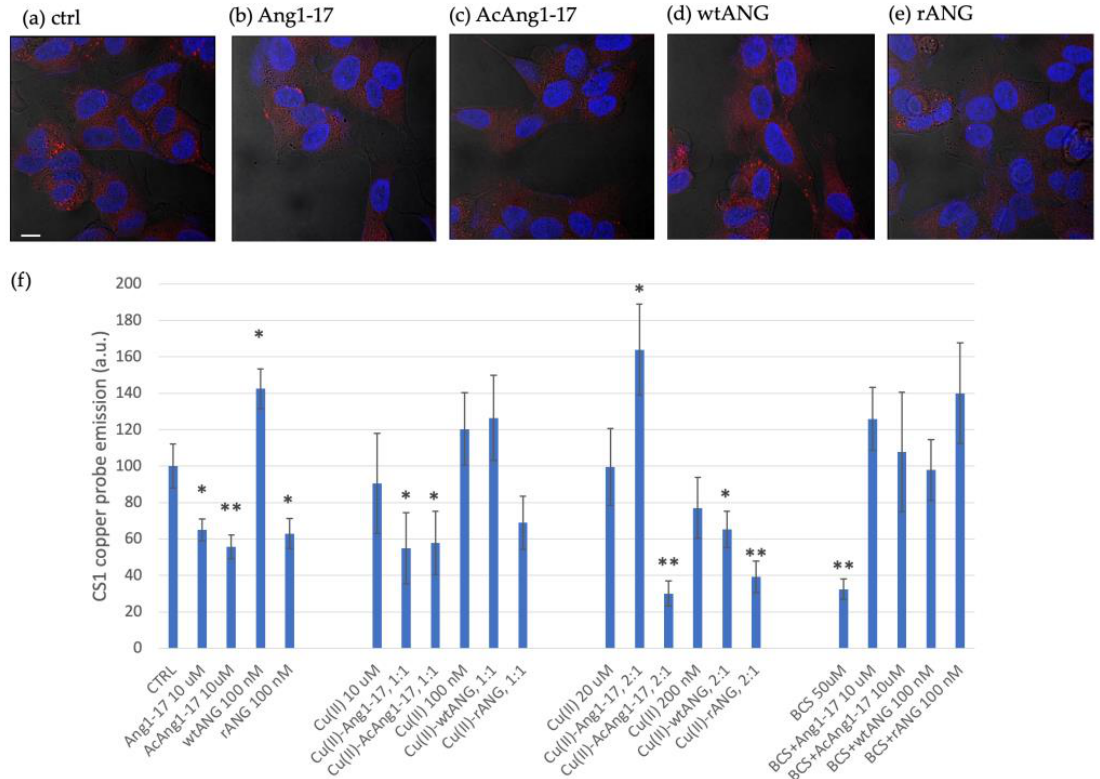
Figure 9. Representative confocal microscopy merged micrographs of fluorescence channels (in blue, nuclear staining, λ ex/em = 405/425–450 nm; in red, CS1-copper probe, λ ex/em = 543/550–600 nm) and optical bright field (in grey) of SH- SY5Y cells untreated ( a , negative control) and after 90 min of treatment with: ( b ) 10 µ M Ang1-17, ( c ) 10 µ M AcAng1-17, ( d ) 100 nM wtANG, and ( e ) 100 nM rANG. Scale bar = 10 µ m. In ( f ) is shown the quantitative analysis of CS1-copper probe emission intensity for the cells treated as follows (four blocks from left to right): in basal medium, untreated or 10 µ M peptide-/100 nM protein-treated cells; in CuSO 4 -supplemented medium, equimolar copper/peptide or copper/protein ratio; in CuSO 4 -supplemented medium, 2:1 copper/peptide or copper/protein molar ratio; in copper deprived medium by pretreatment with BCS extracellular copper chelator, in the absence or presence of 10 µ M peptides/100 nM proteins. Bars represent means ± SEM of at least 3 experiments; (*) = p < 0.05, (**) = p < 0.01, vs. CTRL (untreated cells in basal medium) (Student’s t -test).